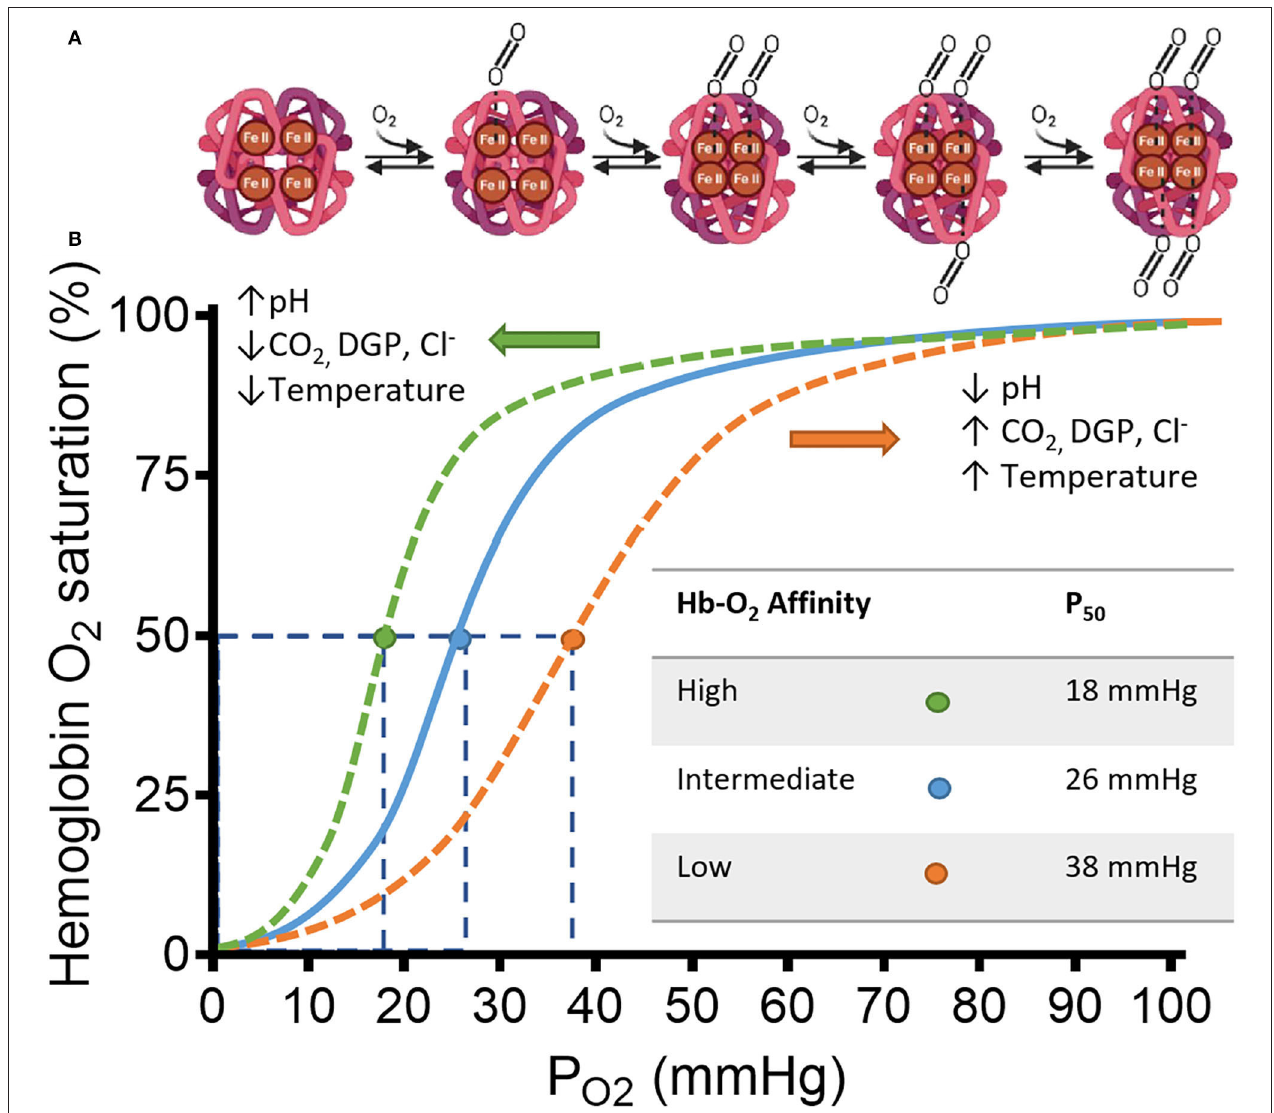
FIGURE 1 | Schematic representation of hemoglobin (Hb) and its affinity for Oxygen (O 2 ) in a classic HB-O 2 dissociation curve. (A) The Hb structure has two α - and two β -subunits (light and dark magenta, respectively). Each subunit has a heme residue with Fe + 2 . Transition from deoxy-Hb (“T” state) to oxy-Hb (“R” state) is represented from left to right. Increasing concentrations of O 2 , changes the structure of hemoglobin to “R” state allowing the cooperative binding of O 2 . The transition starts by displacement of H 2 O from the distal region of the binding pocket by a diatomic ligand such as O 2 . Once the O 2 is sequestered at the distal pocket, the proximity with Fe + 2 from the heme group allows O 2 to bind covalently. Finally, minor electrostatic rearrangements stabilize the new conformation. After this process, the hydrophobic interactions between the other subunits are weakened facilitating bonding between O 2 and the unliganded hemes of the same Hb. (B) Hb saturation curve shows changes in affinity for O 2 by multiple factors. Under low pH, the C-terminal residues of the globin β -chains are protonated, which facilitates O 2 release from heme by shifting the Hb conformation to the low-affinity T-state (12). Similarly, CO 2 , Cl − , and 2,3-diphoglycerate DPG, bind to multiple cationic residues on the N- and C-termini of the α - and β -chains that ultimately stabilizes the T-state conformation of Hb (13, 14). The specific allosteric shift is represented by the orange dashed line displaced to the right from the continuous blue line. The orange dot shows a reduced affinity observed by a higher P 50 -value. The opposite is also true, where the allosteric shift to the left by the above-mentioned factors (represented by the green dashed line) increases the affinity of O 2 for Hb, shown by the green dot and the smaller P 50 -value. Adapted from Storz (15).